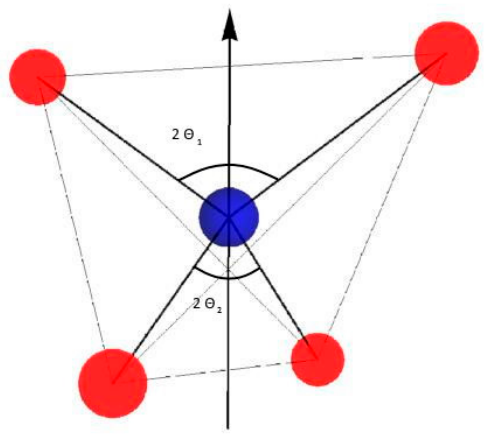
Figure 3. [WO 4 ] tetrahedron with marked angles O-W-O and c -axes.